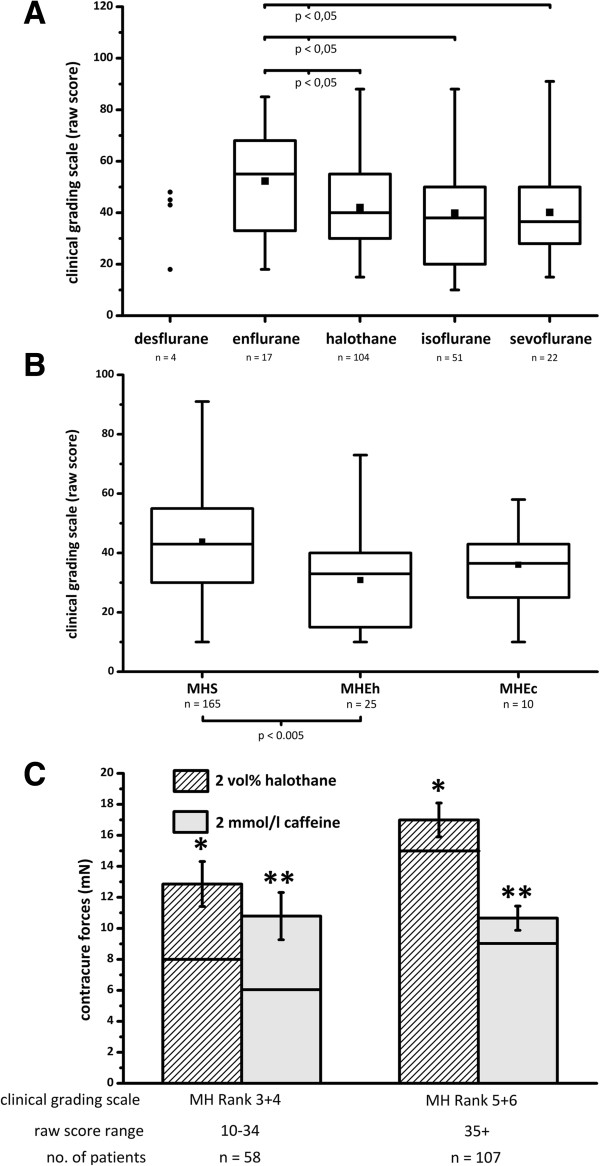
Clinical effects of volatile anesthetics. A: Box and whisker plots showing clinical grading scales (CGS) of 200 malignant hyperthermia susceptible (MHS, n = 165) or equivocal (MHE, n = 35) patients depending on the anesthetic agent used. Enflurane developed a significantly higher CGS compared to halothane, isoflurane and sevoflurane. B: CGS depending on the in vitro contracture test results: malignant hyperthermia susceptible (MHS), malignant hyperthermia equivocal halothane positive (MHEh) and caffeine positive (MHEc). A Mann–Whitney U-test was performed and yielded significant differences between MHS vs. MHEh, i.e. MHS vs. (MHEh + MHEc). C: Patients in this study with clinical crises that resulted in high MH Ranks (5 and 6) developed greater halothane and caffeine contractures than patients with lower MH Ranks (3 and 4). Asterisks (*, **) indicate significant differences. Columns represent mean ± standard error of the mean and black horizontal lines within the columns show median values.